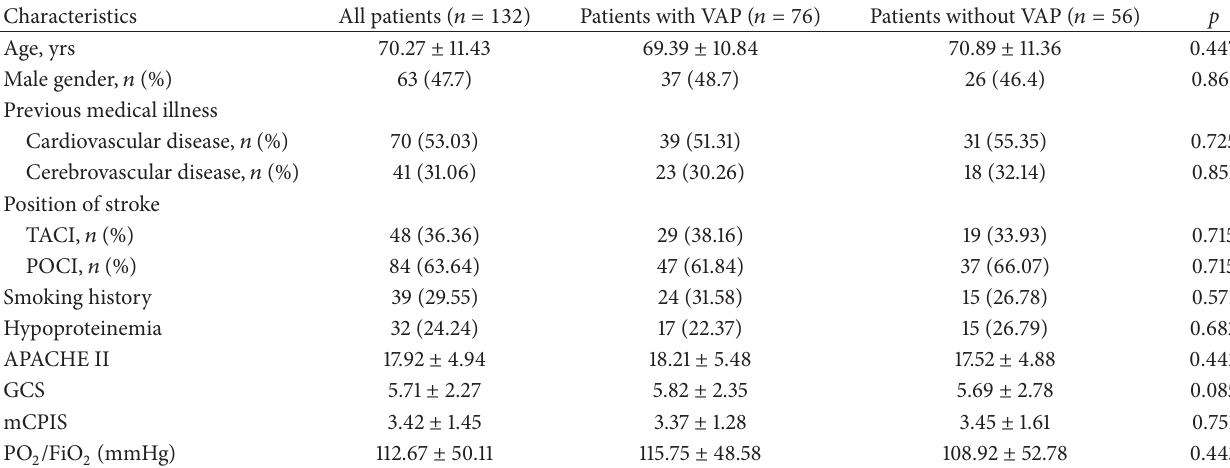
Table 1: Characteristics of the study groups (mean ±